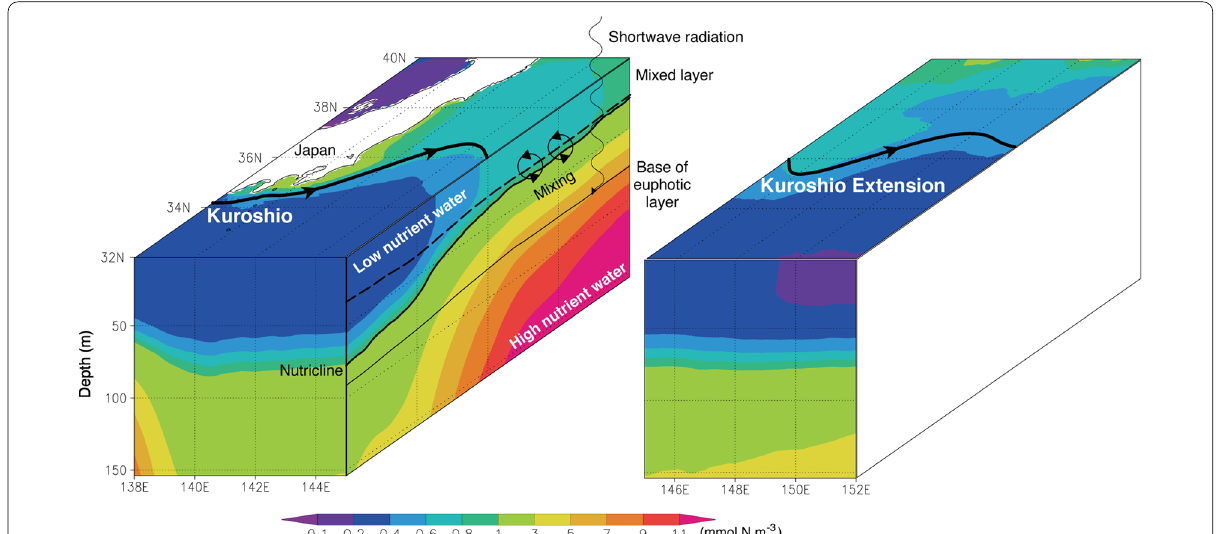
Fig. 1 Schematic diagram of the study area showing three-dimensional structure of nitrogen concentration as well as the major circulation pattern and relevant processes/layers. For nitrogen concentration (shading), nutricline (thick solid line), mixed layer depth (thick dashed line), and the base of euphotic layer (thin solid line), the climatological mean of October from the OFES are